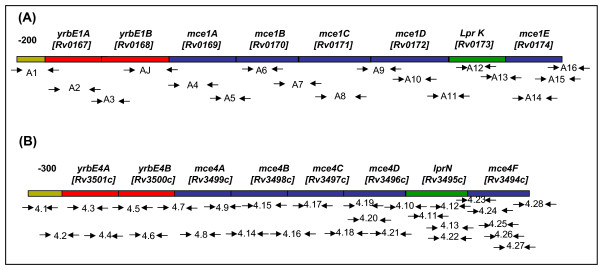
Primers of mce operons. Schematic representation of the position of overlapping primers to completely sequence the genes of (A) mce1 operon (B) mce4 operon.